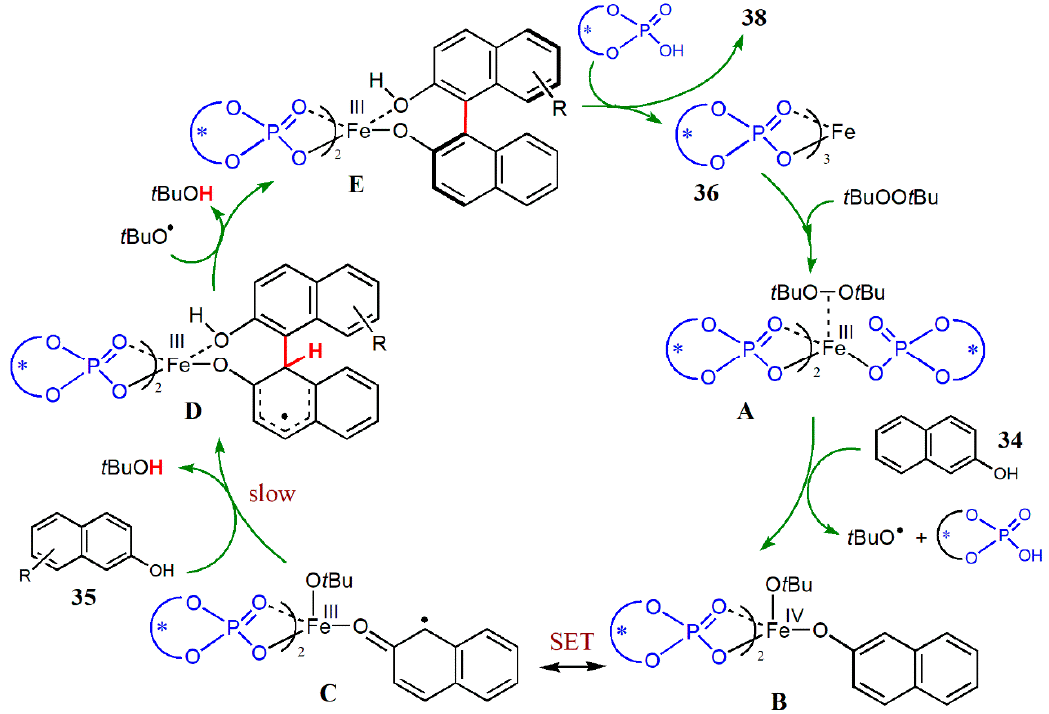
Figure 12. The mechanism proposed for the iron-catalyzed enantioselective CDC of